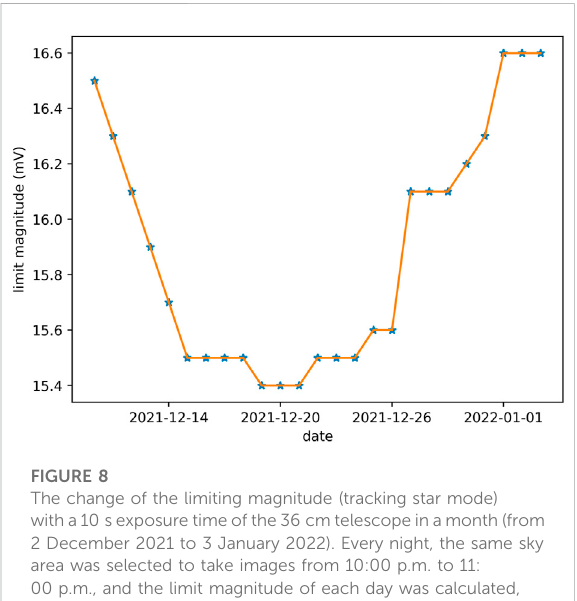
FIGURE 10 The number of objects arcs successfully observed and extracted by a single 36 cm telescope from 2 December 2021 to 3January2022.The bluebarrepresents thenumberofobjectarcs actually observed. The red bar represents the number of object arcs in the